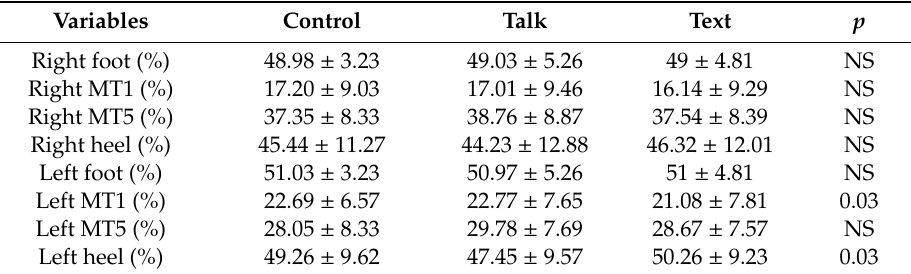
Table 2. Static plantar pressure load distribution.